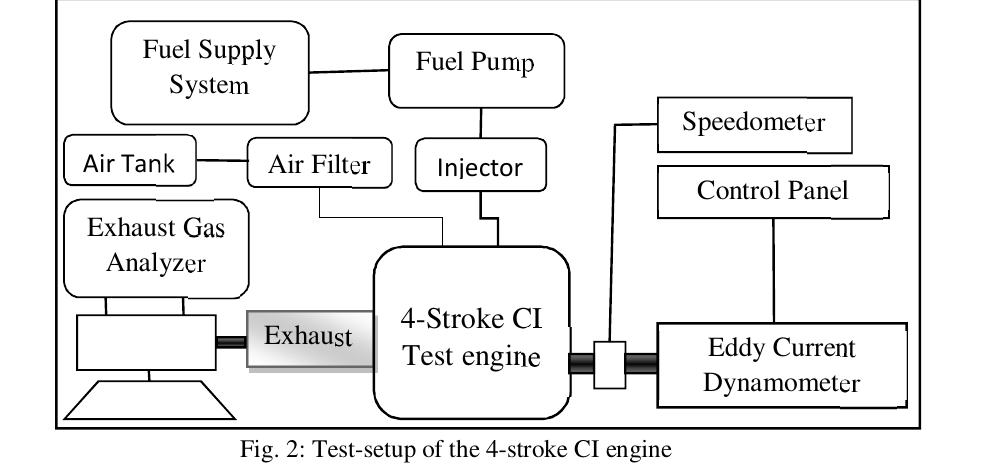
Fig. 2: Test-setup of the 4-stroke CI